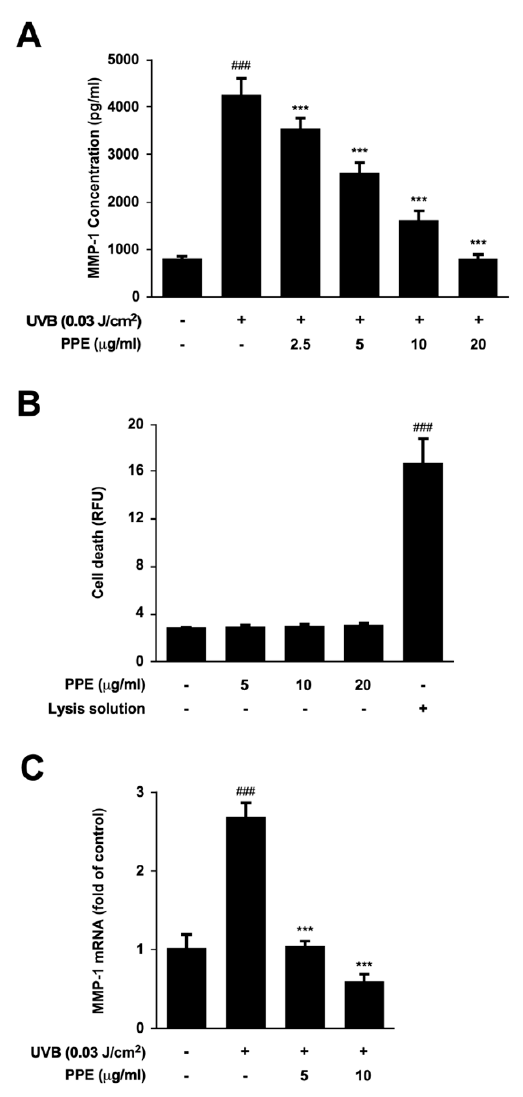
Figure 1. E ff ect of propolis extract on UV-induced matrix metalloproteinase (MMP)-1 expression in human dermal fibroblasts (HDFs). ( A ) Cytotoxicity of propolis extracts (PPE) was measured using the CellTox Green Cytotoxicity Assay kit. Lysis solution was used as a positive control for cell death; ( B ) Hs68 cells were pre-treated with various concentrations of PPE for 1 h before UVB irradiation (0.03 J / cm 2 ). Forty-eight hours after UVB exposure, media was collected and MMP-1 levels in the media were determined by ELISA; ( C ) MMP-1 mRNA levels were examined by RT-PCR. Data are shown as mean ± S.D. ### p < 0.001 compared with untreated control; *** p < 0.001 compared with the group of UVB exposure alone.